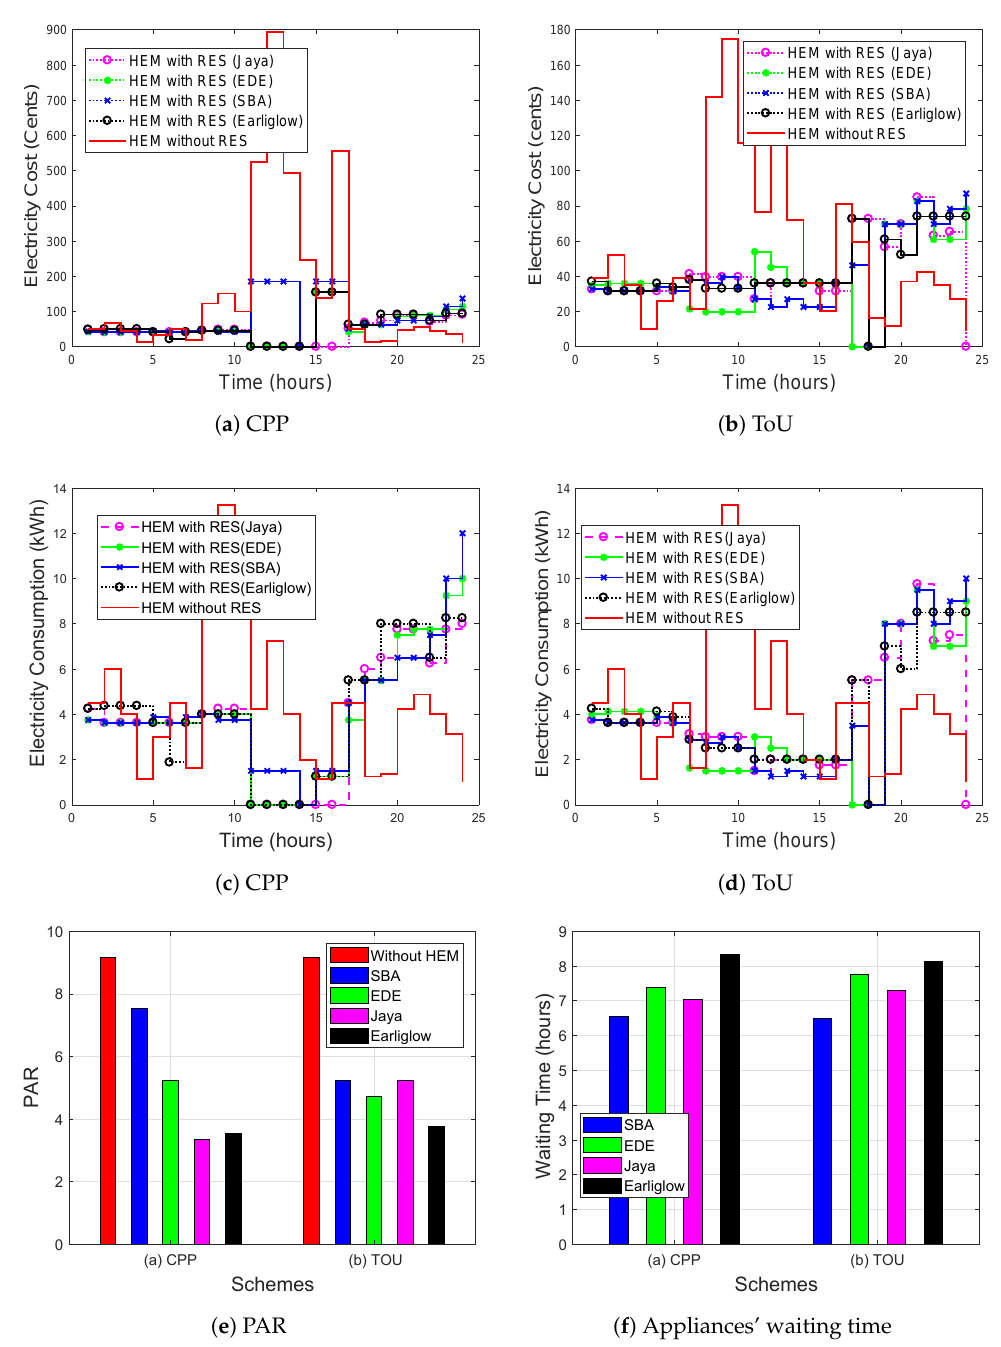
Figure 6. ( a ) hourly electricity cost with RES using CPP; ( b ) hourly electricity cost with RES using ToU; ( c ) hourly electricity consumption with RES using CPP; ( d ) hourly electricity consumption with RES using ToU; ( e ) PAR; ( f ) appliances’ waiting